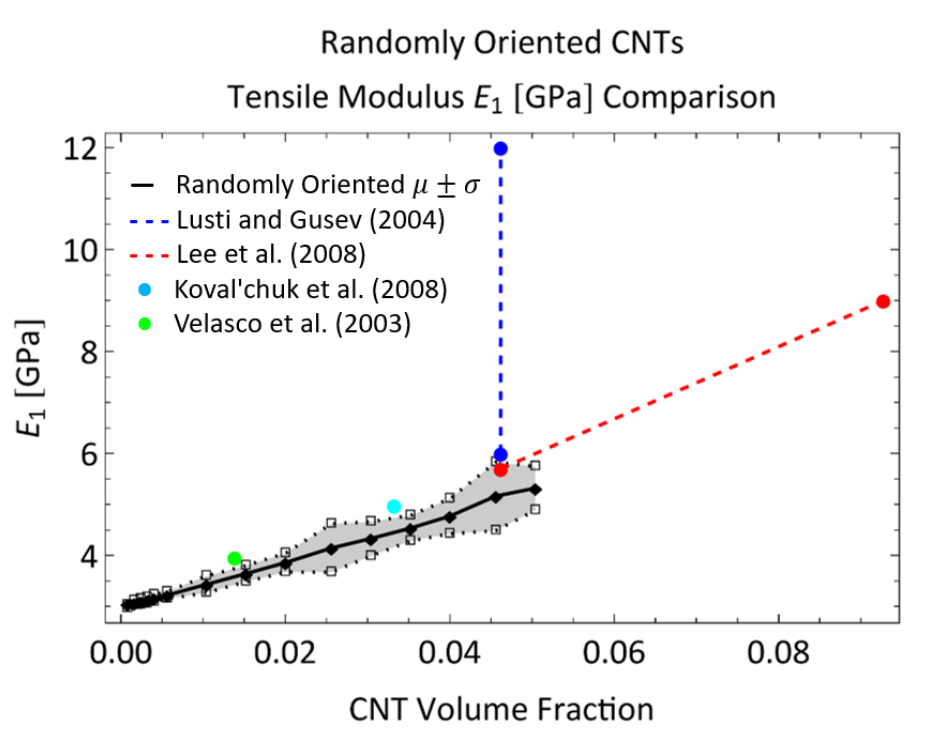
Figure 12. Comparing engineering constant E 1 for randomly oriented straight CNTs with